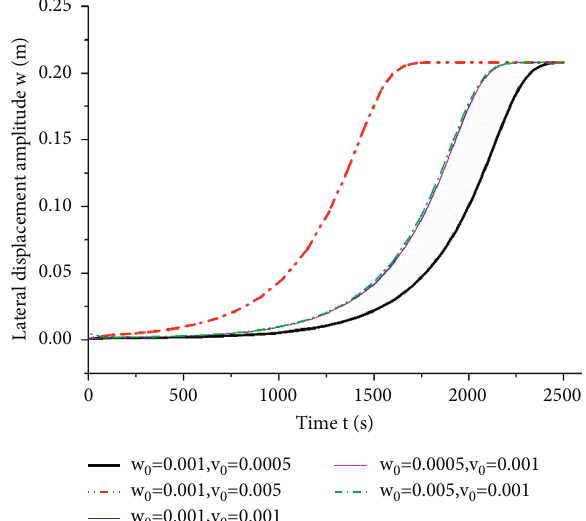
Figure 11: Time history diagram of lateral displacement amplitude under different initial conditions.